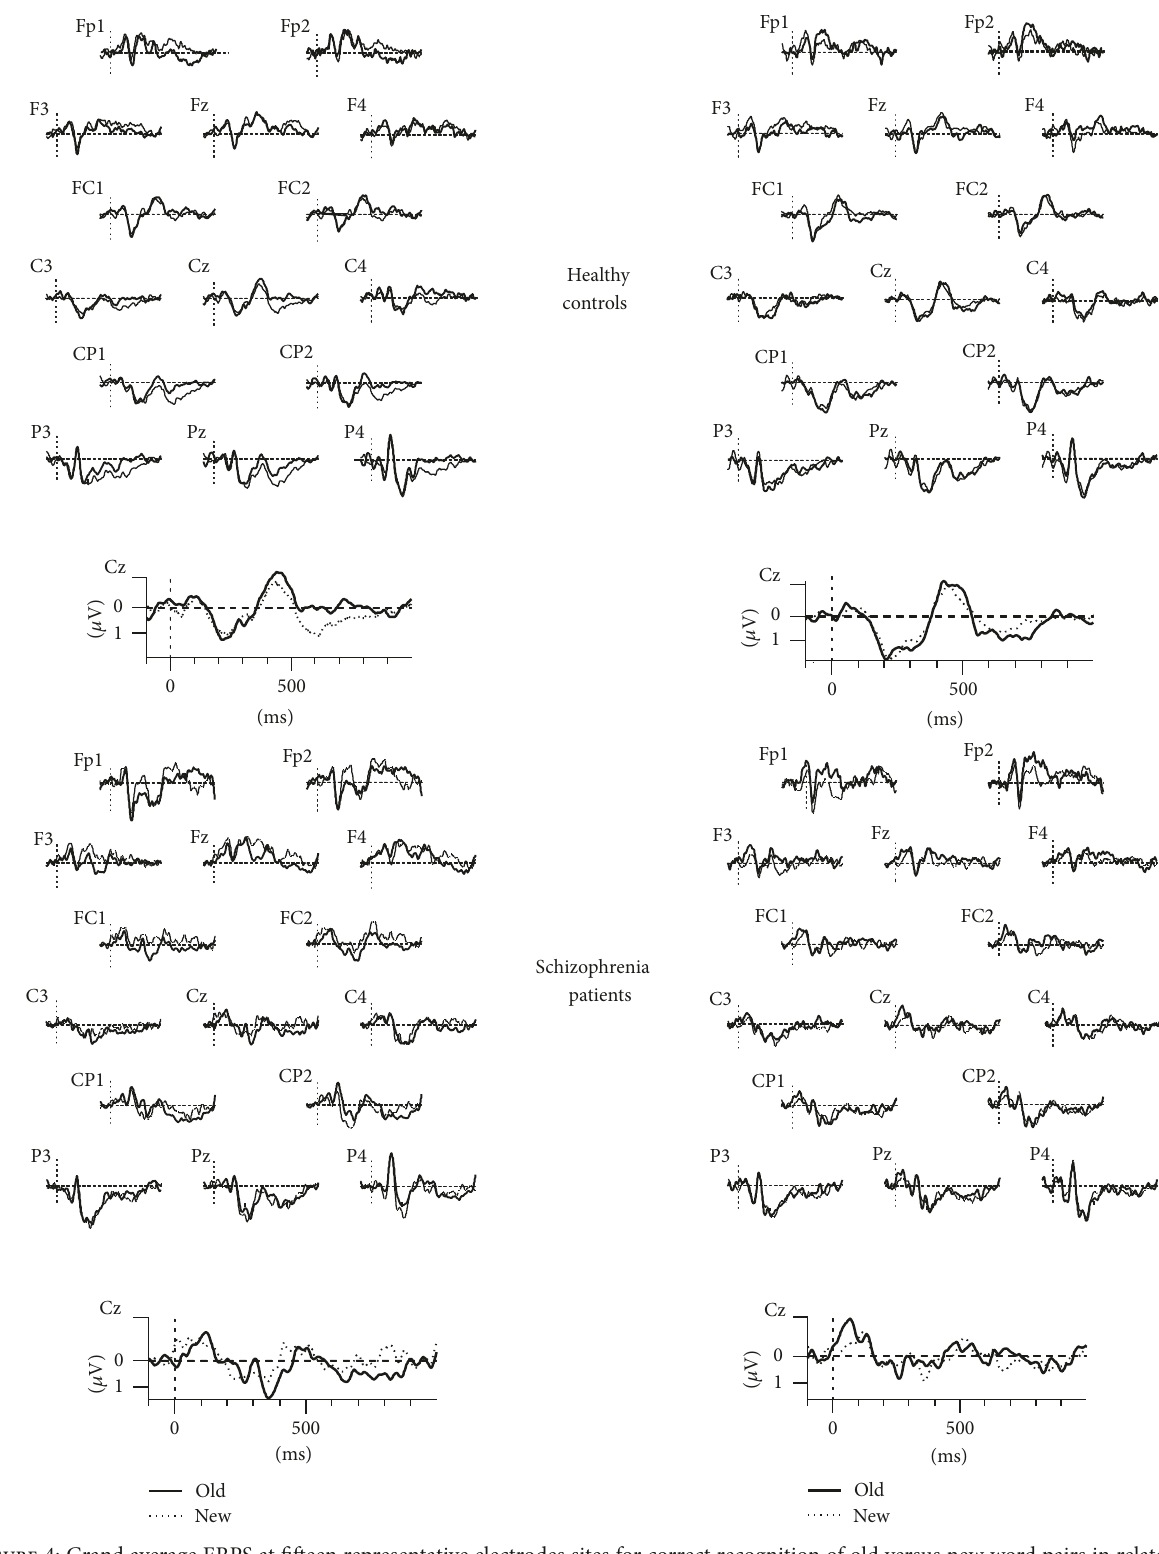
Figure 4: Grand average ERPS at fifteen representative electrodes sites for correct recognition of old versus new word pairs in related and unrelated conditions during the test phase, in healthy controls and schizophrenia